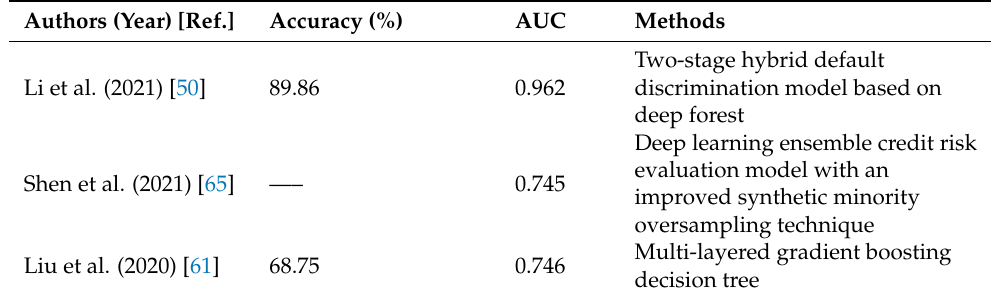
Table 11. Accuracy and area under the receiver operating characteristic curve (AUC) values of deep-learning-based classifiers for the Taiwanese